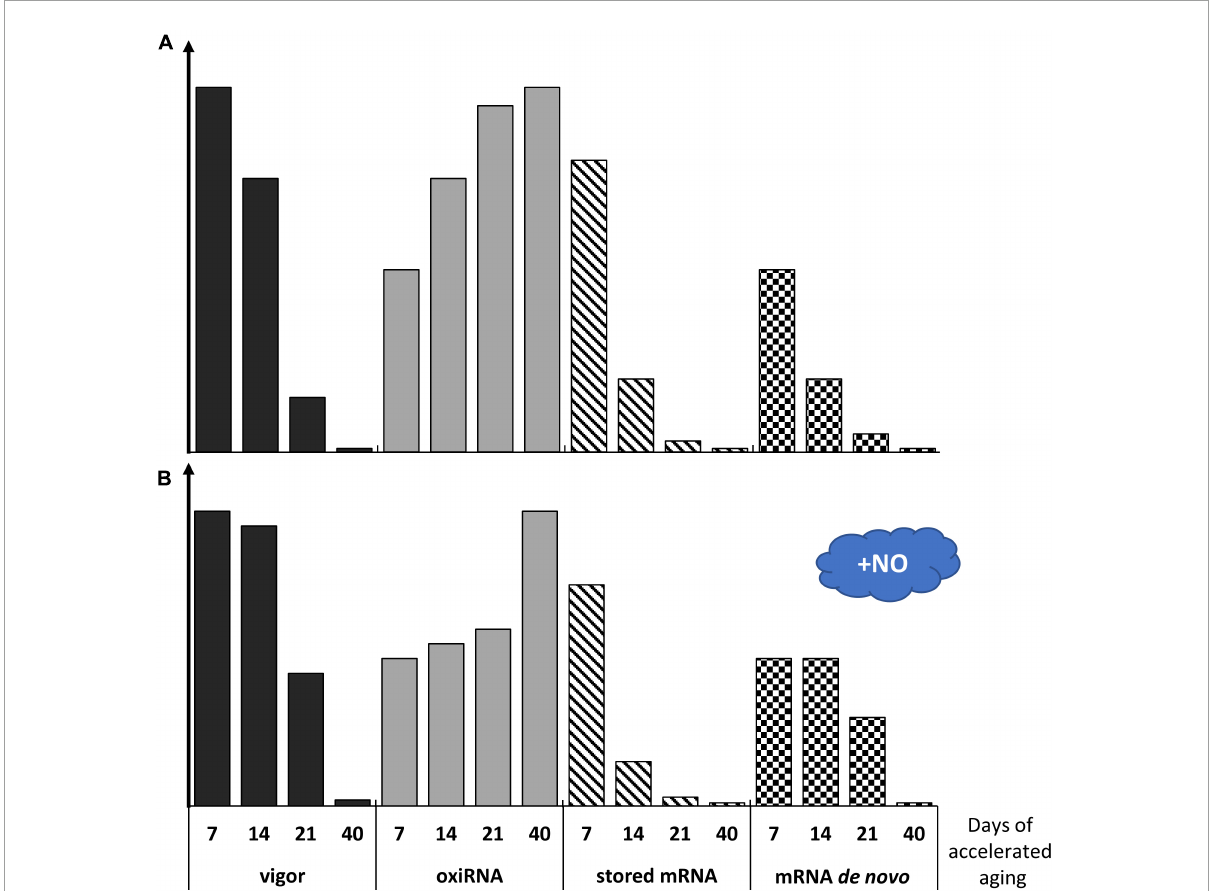
FIGURE8 The figure describes the vigor of apple embryos in dependence on the progression of seed accelerated aging concerning the changes in the level of the oxidized RNA (oxiRNA), stored mRNA, and newly synthesized RNA (mRNA de novo ) in the control embryos, non-treated with NO (A) , and the embryos shortly fumigated with NO (B) . The height of the bars filled with color (vigor-black and oxiRNA-gray) is proposed according to data by Ciacka et al. (2022). The height of the bars filled with sloping lines–stored mRNA, is estimated according to Zhao et al. (2020a, 2020b). The height of the checkered bars–mRNA de novo is